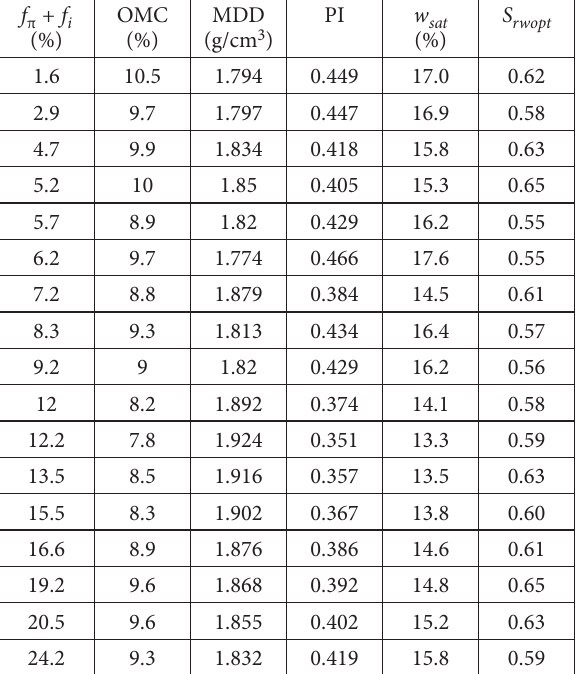
Table 1. The compactibility parameters of the tested soils